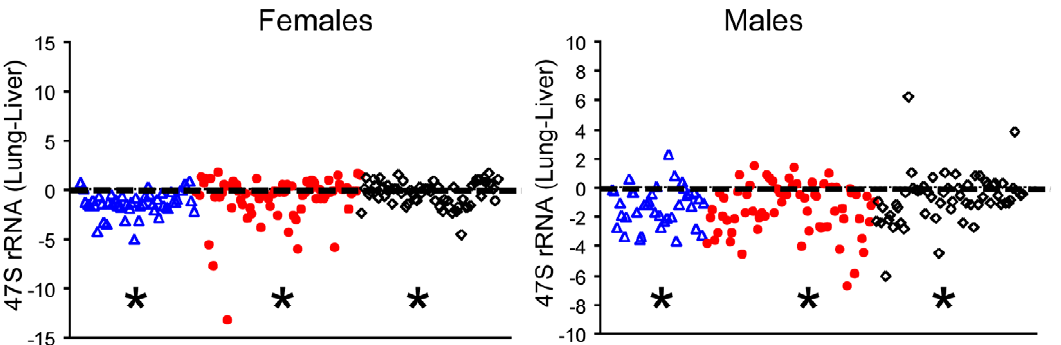
Figure 5. Differential rRNA level between tissues. The scatter plot of arithmetic difference (y-axis) between lungs and livers of individual mice in 3 paternal treatment lineages shows higher rRNA level in livers compared with lungs (blue: acidic saline; red: Cr; black: untreated). *Denotes p , 0.003 (paired T test) and identifies positive/negative mean differences by its location above/below the zero reference line.